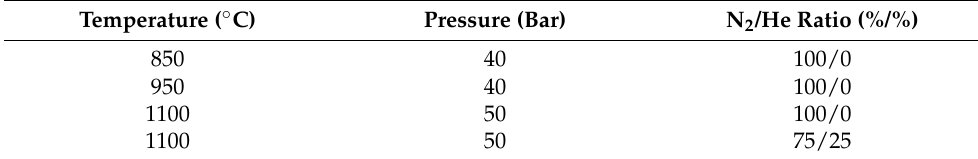
Table 1. Cold gas spraying (CGS) parameters of AISI 316L with Impact 5/11 system. Temperature ( ◦ C) Pressure